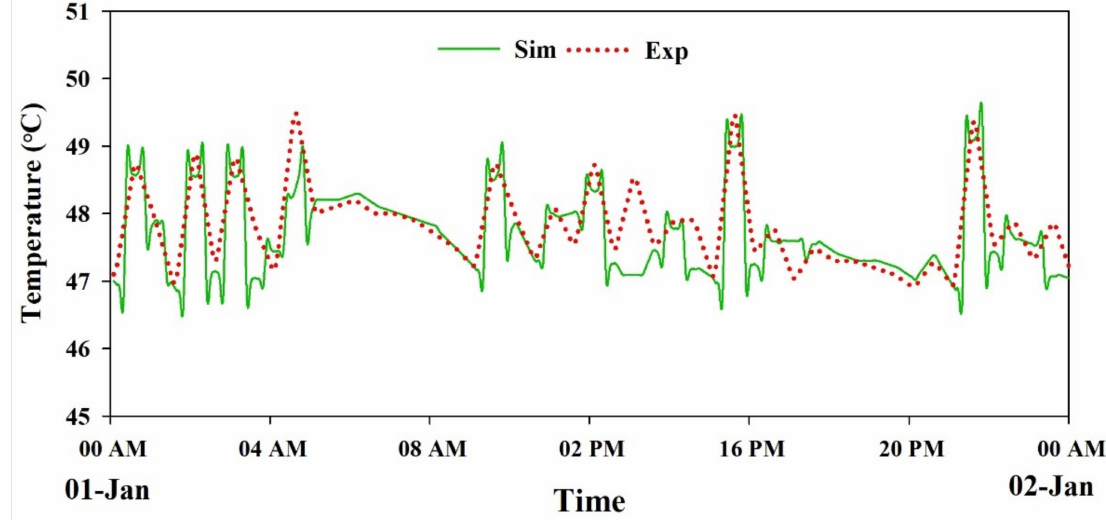
Figure 13. Heat pump output water temperature